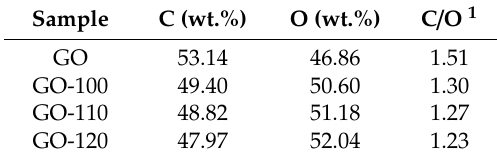
Table 1. Contents of C and O of different samples.